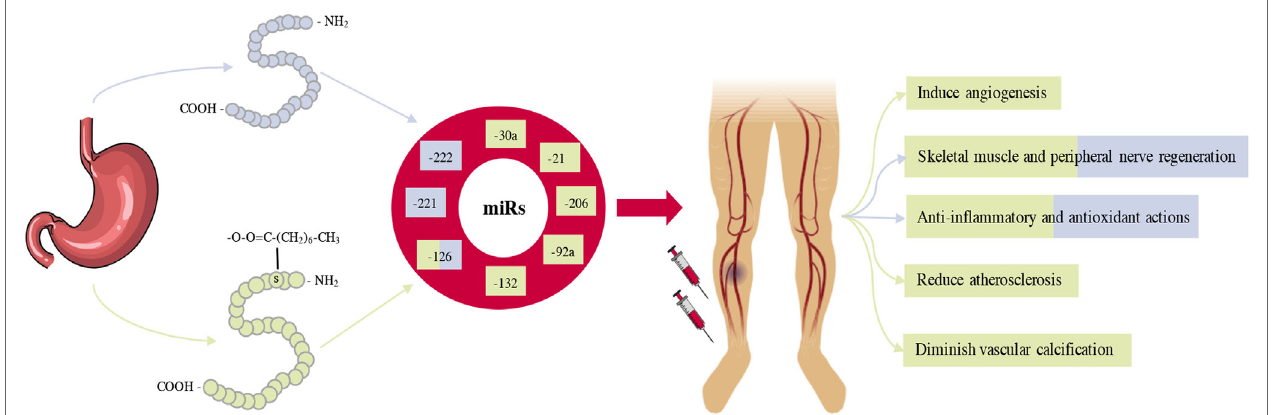
FiGURe 2 | A schematic overview summarizing the role of ghrelin administration in the treatment and management of critical limb ischemia (CLI). Ghrelin is predominantly produced in the stomach and circulates in two forms, Acylated ghrelin (AG) and des-acylated ghrelin (Des-AG). Most of the biological effects of AG and Des-AG in pre-clinical models of CLI appear to be closely related to alterations in several pro-survival microRNAs (miRs). Given ghrelin administration can regulate several miRs, which in turn control a significant proportion of genes, ghrelin administration can result in improved limb perfusion, muscle quality, and ultimately,